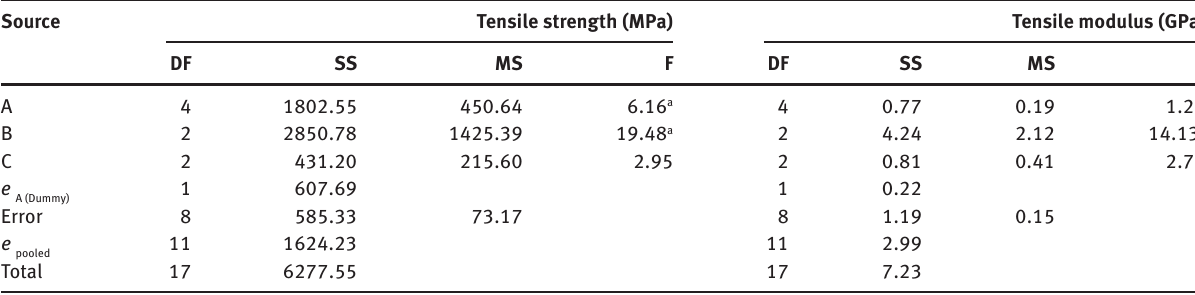
Table 4: ANOVA table for tensile properties of composites. Source